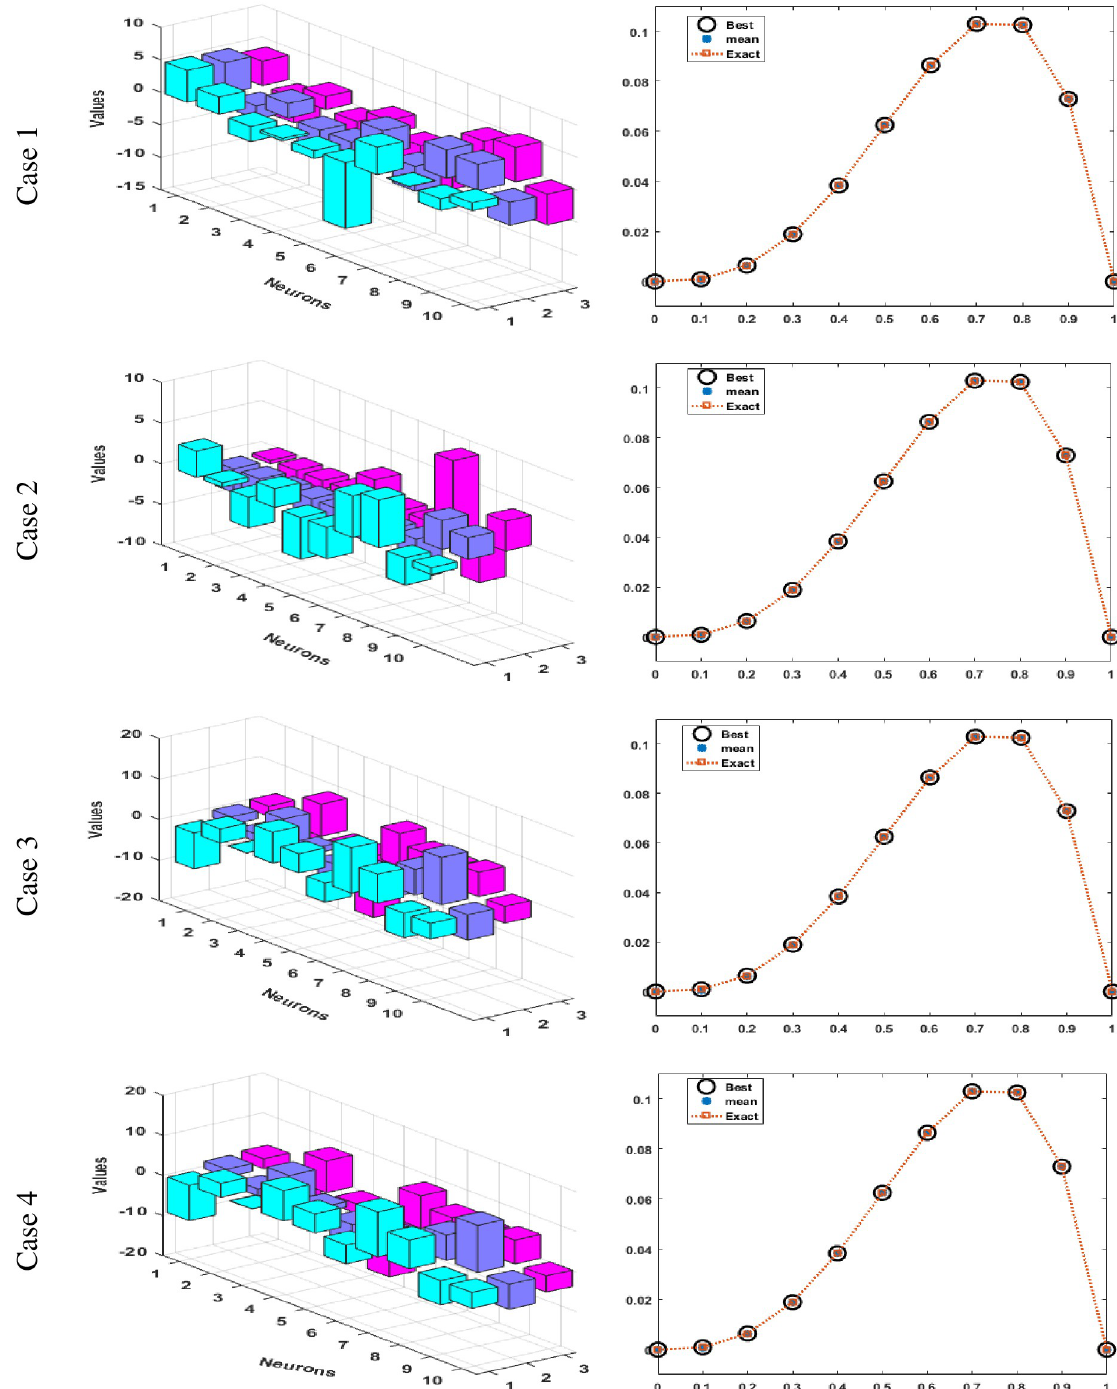
Fig 2. Set of weights and comparison of result for all cases of problem 1.